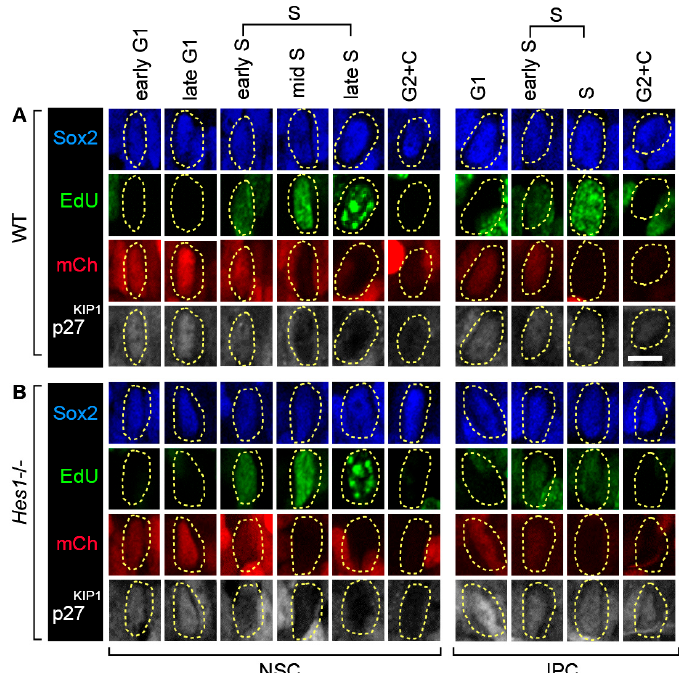
Figure 5. Multiprobe immunostaining of OE NSCs and IPCs using antibodies to detect Sox2, mCherry-hCdt1 (30 / 120) (abbreviation: mCh), and p27 KIP1 , and in addition with Click-iT to detect EdU. ( A ) Wildtype (WT), ( B ) Hes1- / - . p27 KIP1 levels are upregulated in Hes1- / - IPCs, but not in NSCs. Scale bar = 10 µ